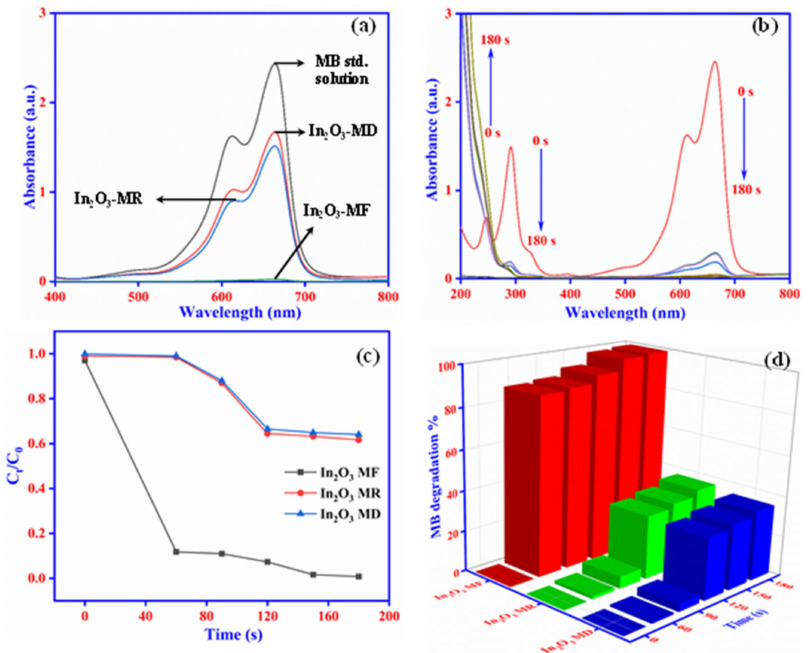
Figure 7. UV-vis spectra of MB degradation with In 2 O 3 -MF, In 2 O 3 -MR, and In 2 O 3 -MD catalysts ( a ); photocatalytic degradation of MB using In 2 O 3 -MF as a catalyst ( b ); plots of C t /C 0 vs. contact time using In 2 O 3 -MF, In 2 O 3 -MR, and In 2 O 3 -MD catalysts ( c ); MB degradation % vs. contact time plot ( d ).